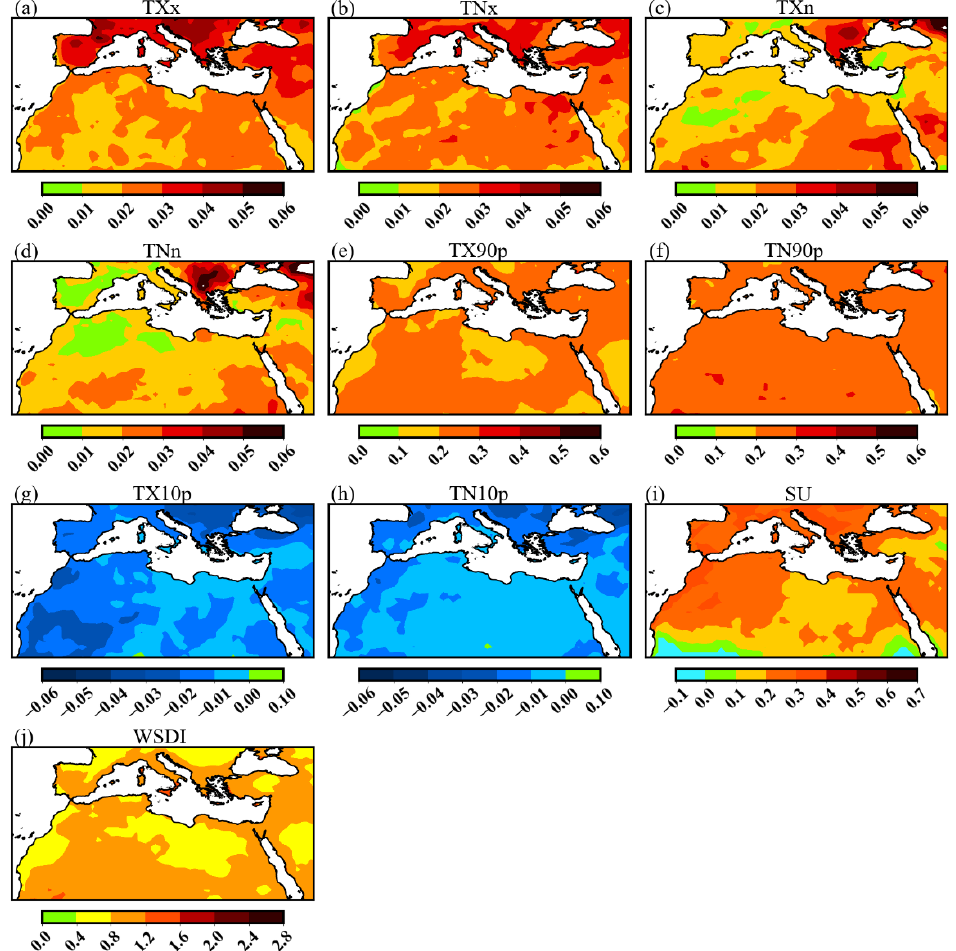
Figure 11. Spatial trends of extreme temperature from the multi-model ensemble mean of CMIP6 GCMs bias-adjusted data for the mid-future (2041–2070) relative to the baseline period (1995–2014) for the SSP2-4.5 scenario. The indices reflect the intensity (TXx, TNx, TXn and TNn) ( a – d ), frequency (TX90p, TN90p, TX10p, and TN10p) ( e – h ) and duration (SU and WSDI) ( i , j ) of the extreme events.